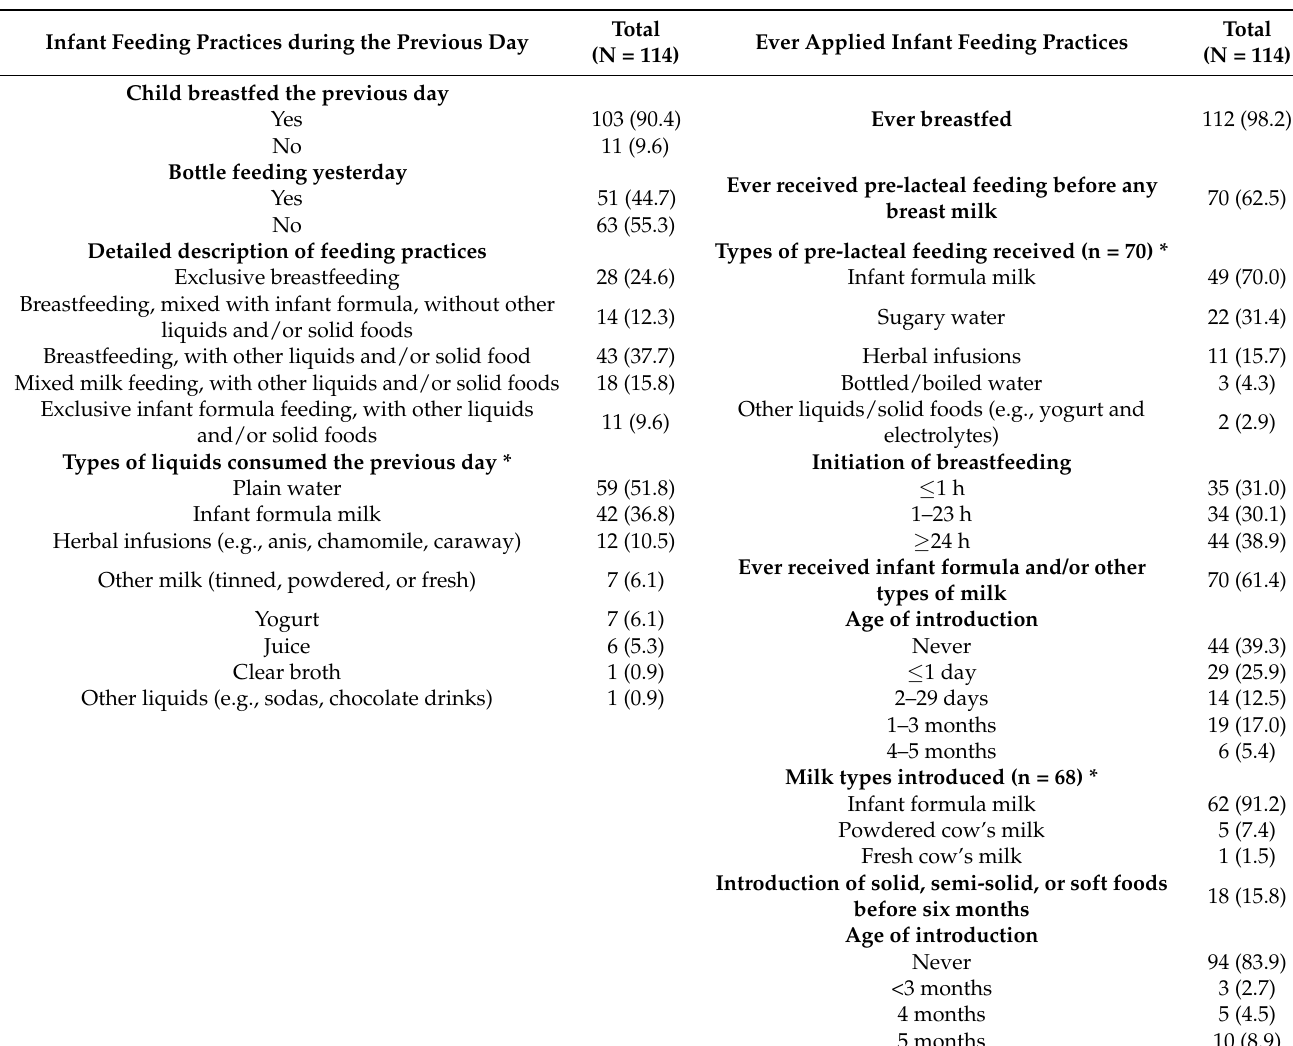
Table 2. Feeding practices of infants under six months among Syrian refugees in Greater Beirut, Lebanon